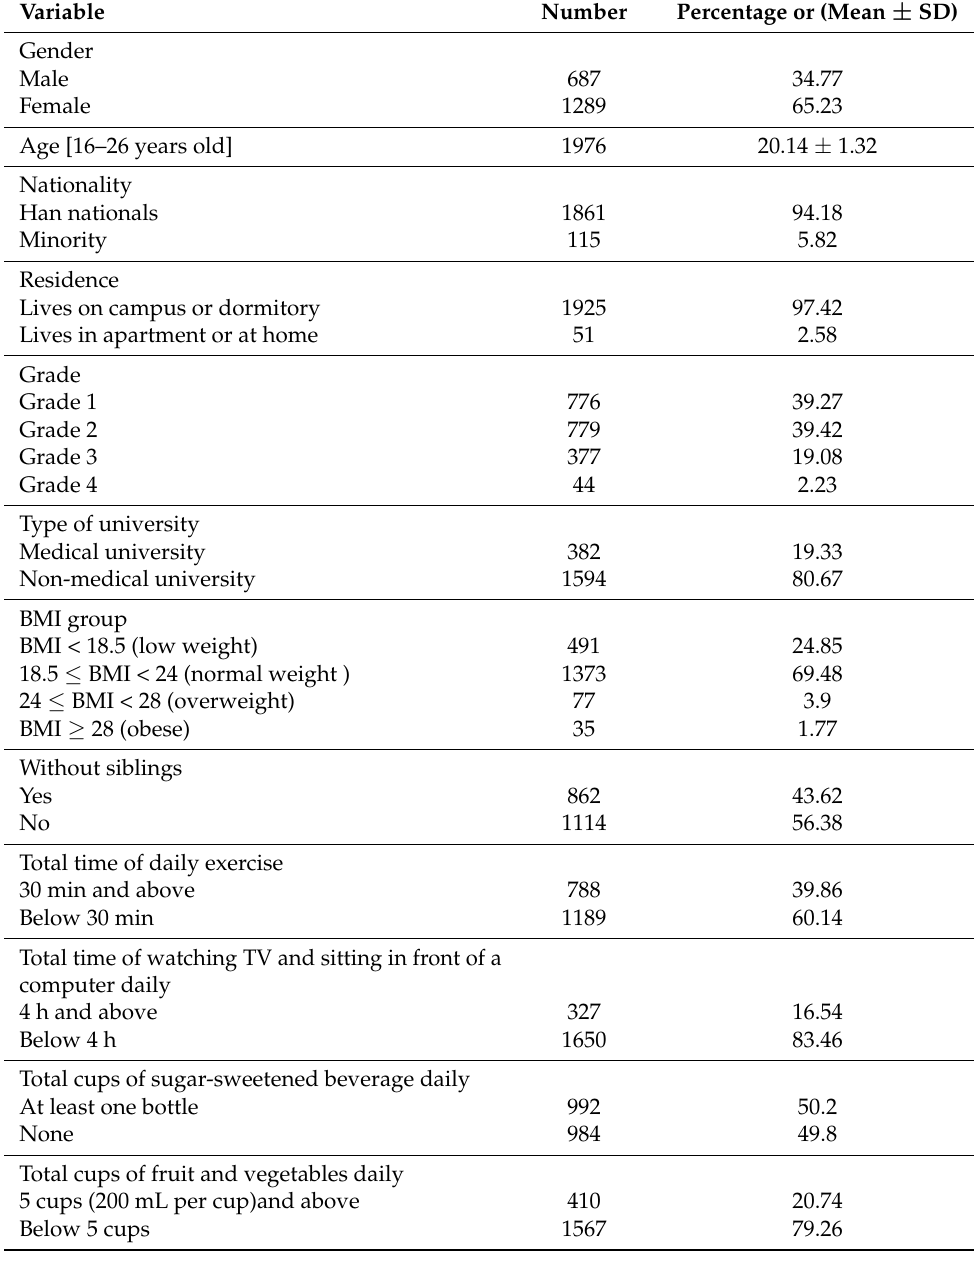
Table 1. Demographic characteristics of undergraduate students in Chongqing, China,